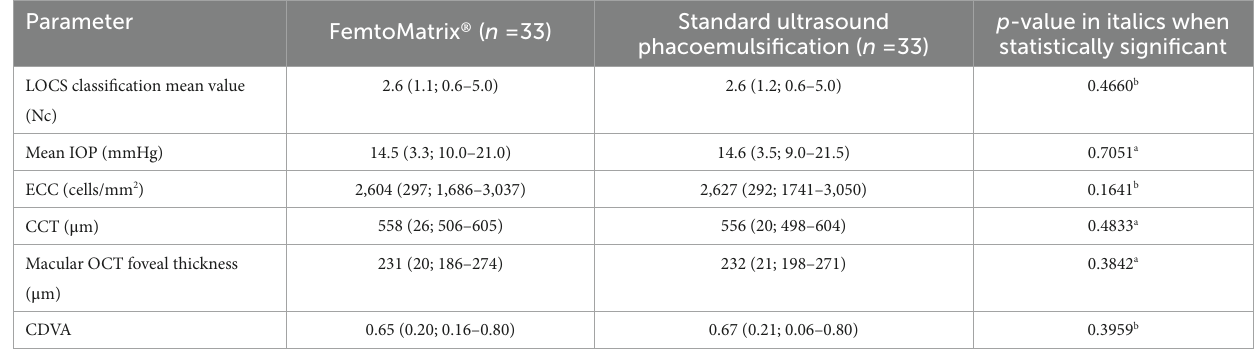
TABLE 1 Baseline characteristics of the